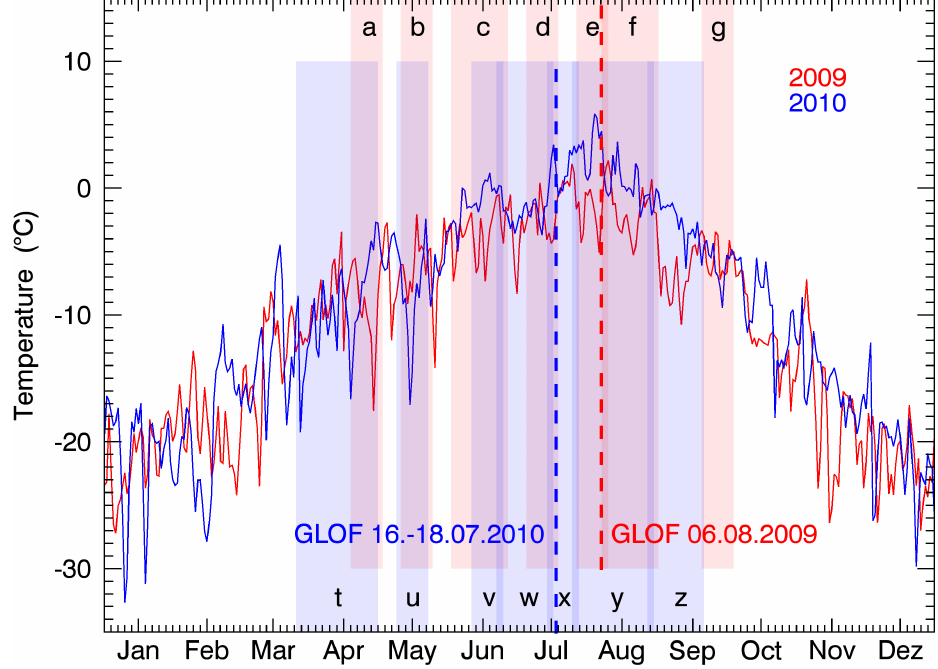
Figure 7. Daily 2m-temperature values for 2009 (red) and 2010 (blue) at the Southern Inylchek area taken from the ECMWF operational model. The shaded rectangles mark the time frame that is covered by the surface velocity results shown in Figure 5, whereas lower-case characters refer to the according images. The dashed lines mark the GLOF in 2009 and 2010,